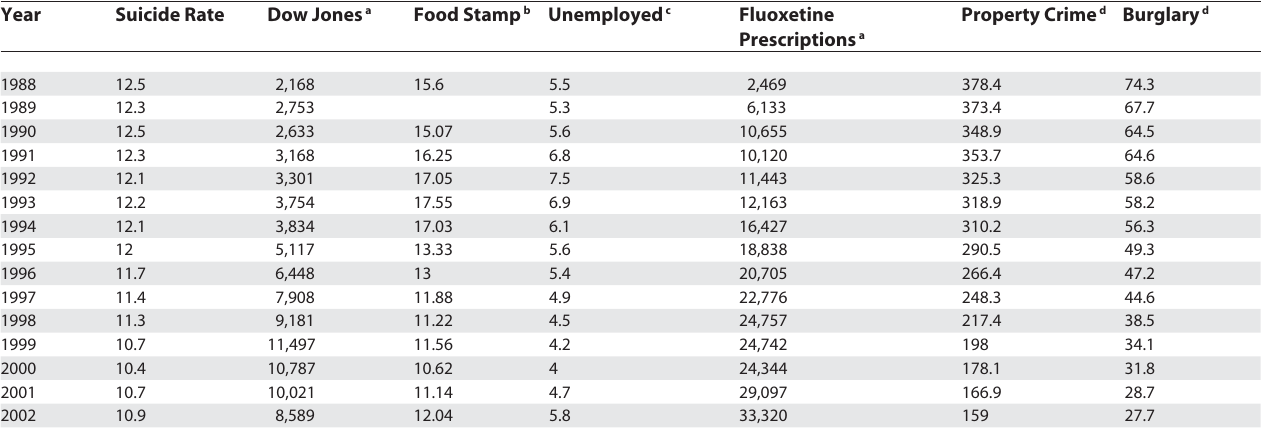
Table 1. Raw Data by Year